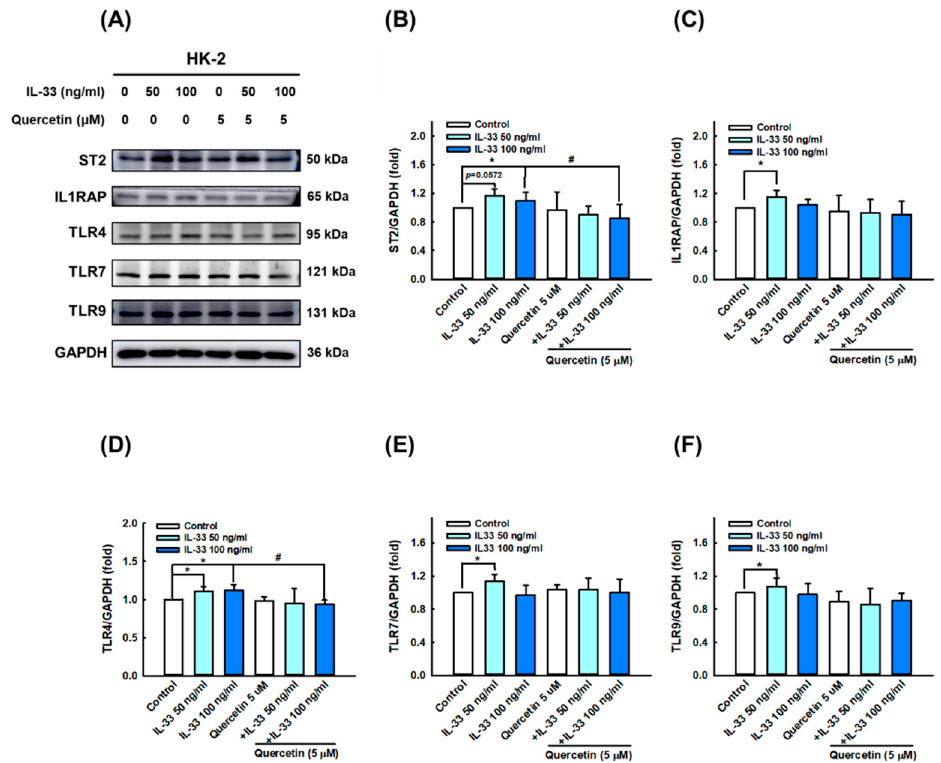
Figure 6. Quercetin suppressed the expression of receptor proteins in human renal tubular epithelial cell line. HK-2 cells were co-cultured with 5 μ M quercetin and 50 ng/mL or 100 ng/mL recombinant human IL-33 for 48 h. ( A – F ) Immunoblots and quantitative histograms showing the results of Western blotting analysis for the expression of ST2, IL1RAP, TLR4, TLR7, and TLR9 proteins. Data are expressed as mean ± SD ( n = 3). * p < 0.05 versus control group; # p < 0.05 versus corresponding IL-33-stimulated group.